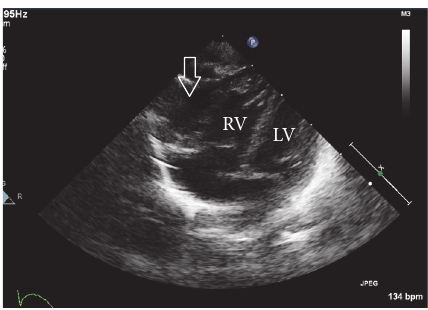
Figure 3: Postnatal ultrasound: four-chamber view showing the diverticulum arising from the right ventricle. LV, left ventricle; RV, right ventricle. Arrow indicates the diverticulum.